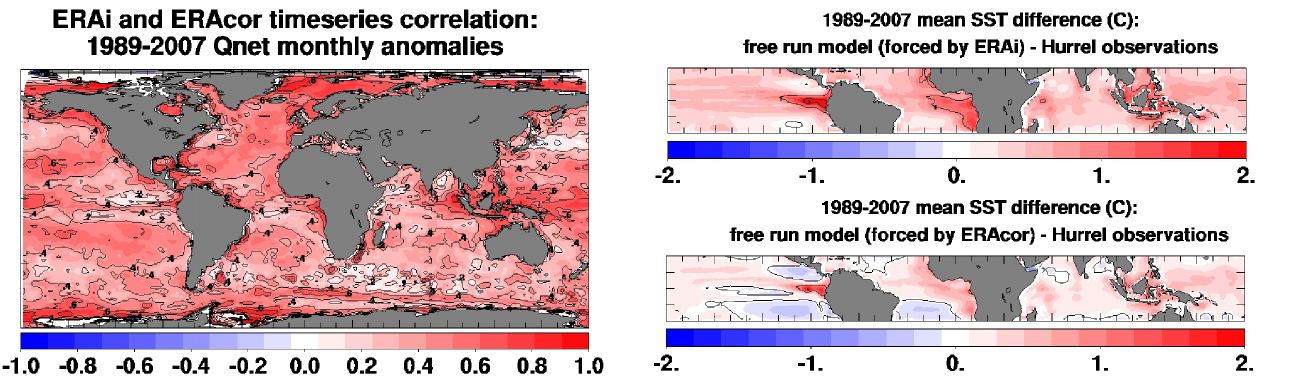
Fig. 10. 1989–2007 ERAi and ERAcor monthly Q net anomalies time series correlation map. Isocontours from − 1 to 1 by 0.2.